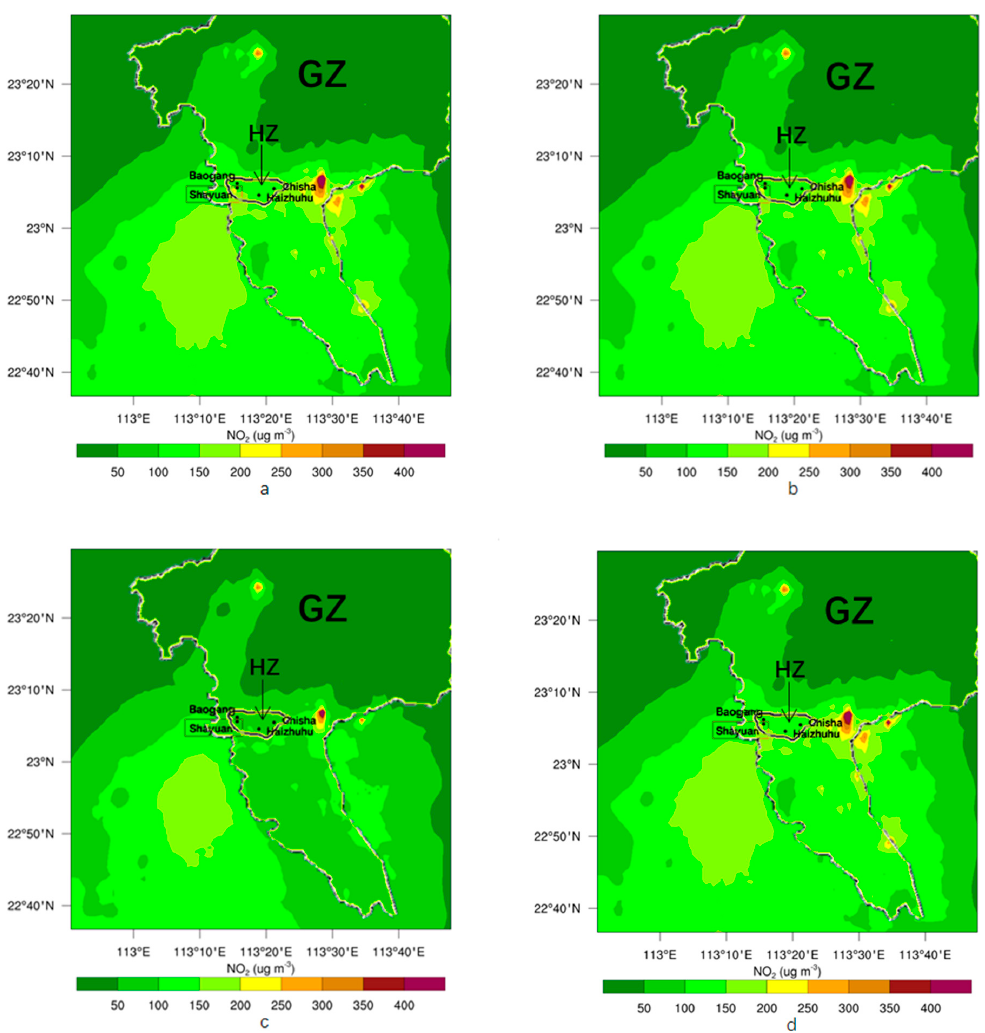
Figure 8. Maps of the simulated mean NO 2 concentration distribution during the period 0000 BJT, 20 January, to 2300 BJT, 21 January, over Haizhu for 2020 scenarios (a: 2020A; b: 2020B; c: 2020C; d: 2020D; HZ: Haizhu; GZ: Guangzhou).